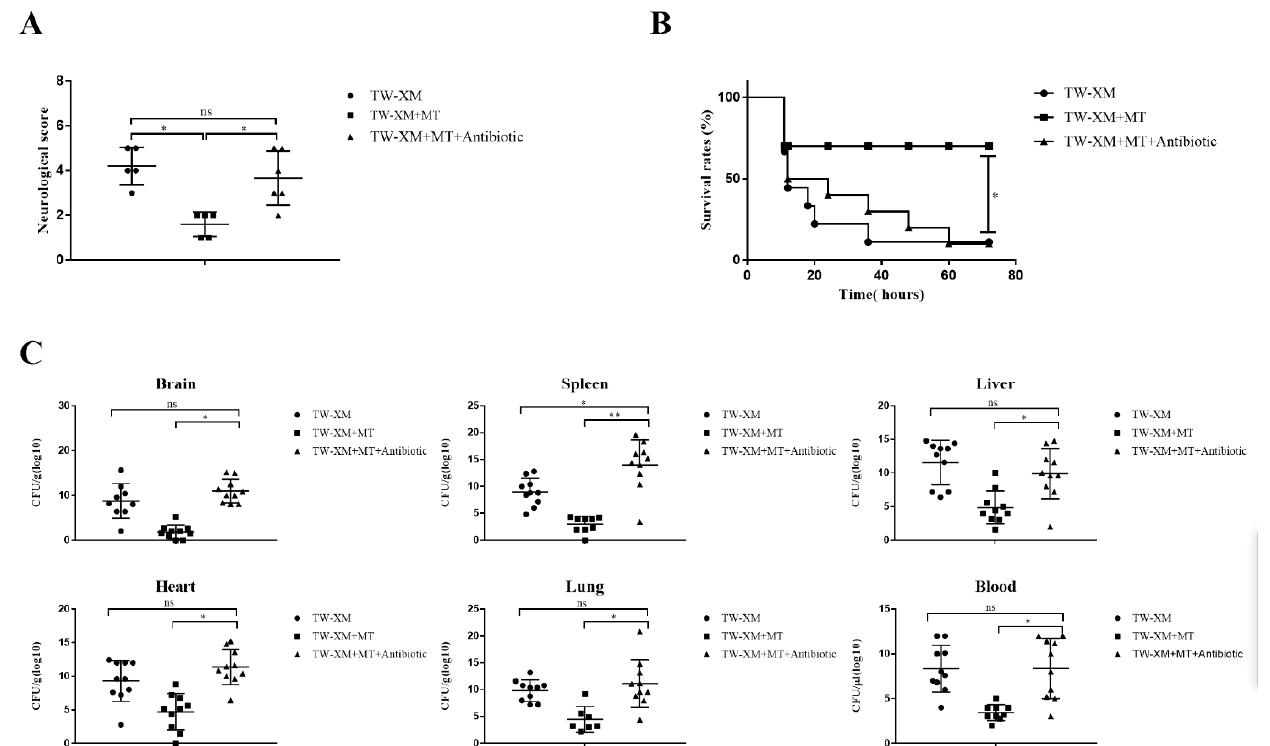
Figure 5. In the absence of intestinal microbiota, melatonin failed to alleviate neurological symptoms, increase survival rates, and reduce bacterial counts of tissues and blood in TW − XM − infected ICR mice. ( A ) The neurological symptom scores of ICR mice in different groups were analyzed at 12 h postinfection. ( B ) The survival rates of ICR mice in different groups were analyzed. ( C ) The loads of TW − XM in brain, spleen, liver, heart, lungs, and blood were analyzed in the TW − XM group and the TW − XM + MT group at 12 h postinfection. Each point represents one mouse. All data were determined by one-way ANOVA and expressed as means ± SEM. * p < 0.05, ** p < 0.01, , ns p > 0.05.